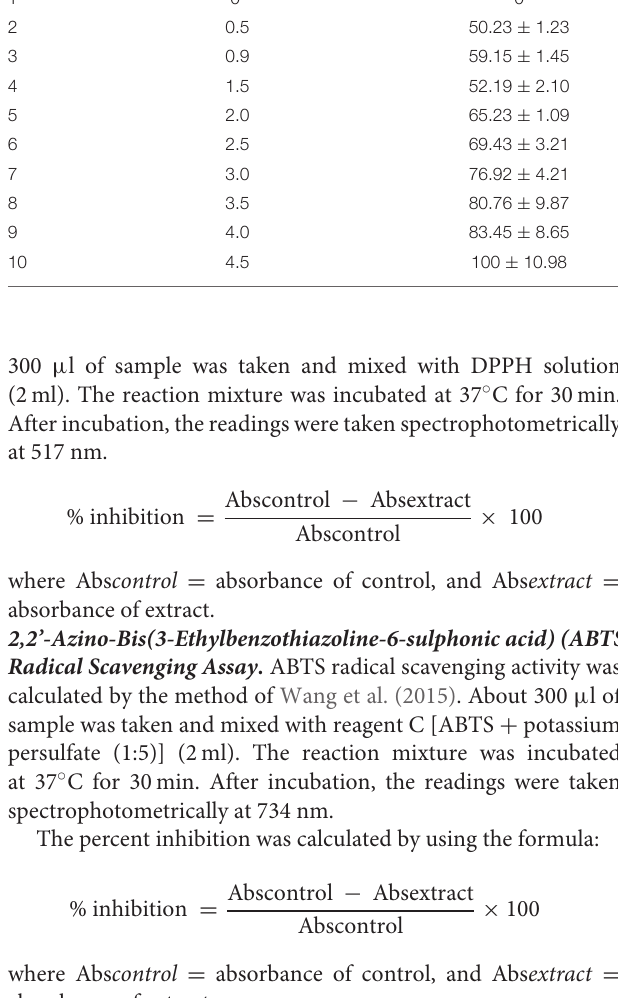
TABLE 2 | Efficacy of EO of Zanthoxylum armatum DC on %age mycelial inhibition and %age reduction in number of spores of Alternaria alternata (Fr.) Keissl. S. No Concentration of EO of Z. armatum ( µ